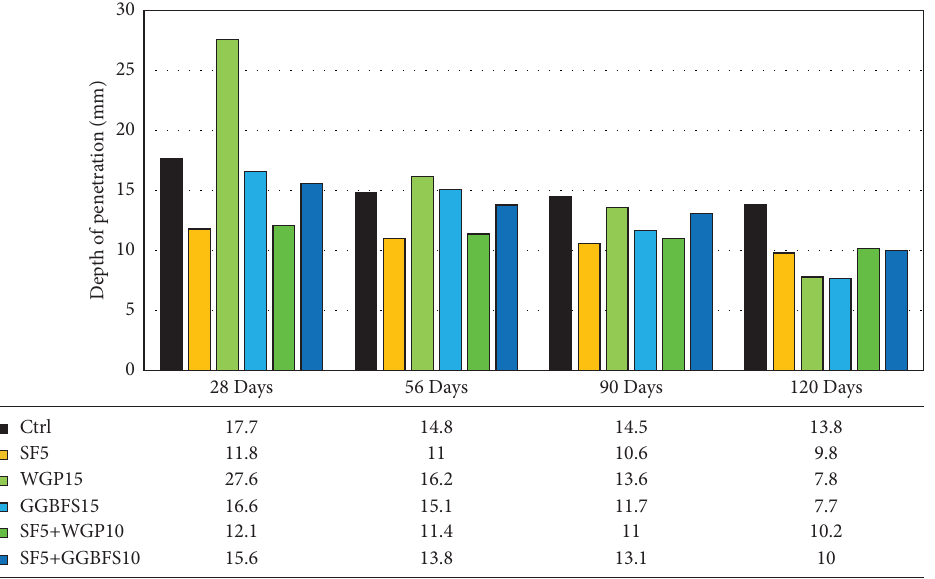
Figure 13: Depth of penetration of water under pressure results of concrete